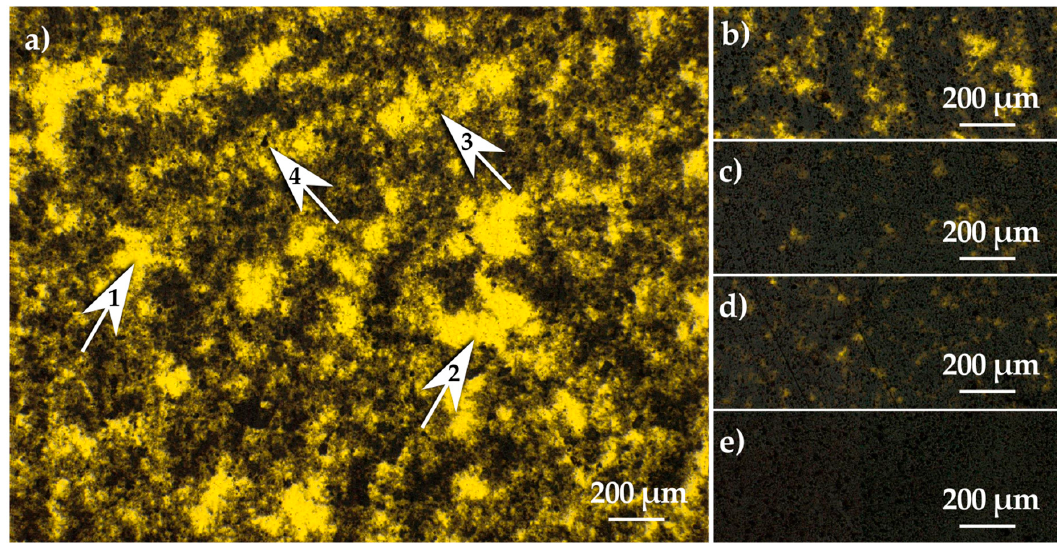
Figure 11. Bright field optical microscopy of MWCNTs ( a ) 0.25, ( b ) 0.5, ( c ) 0.75, ( d ) 0.1, and ( e ) 0.2 wt.%.